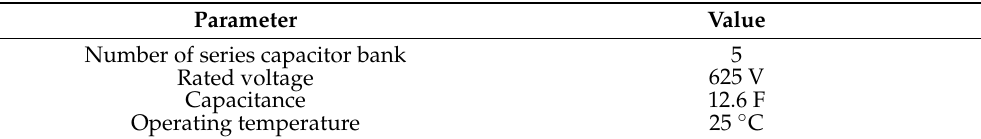
Table 3. SC bank